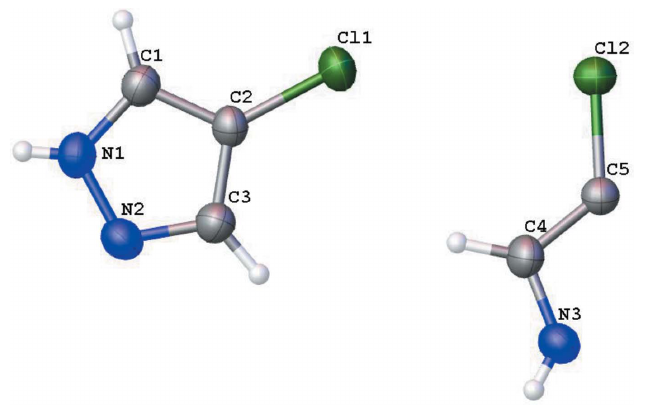
Figure 1 Perspective view of the asymmetric unit of 4-chloro-1 H -pyrazole. Displacement ellipsoids are shown at 50% probability and half the disordered protons are removed for clarity.